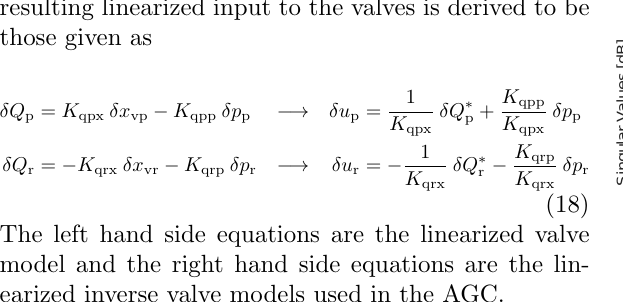
Figure 10: Singular values comparison between system with ideal and non-ideal